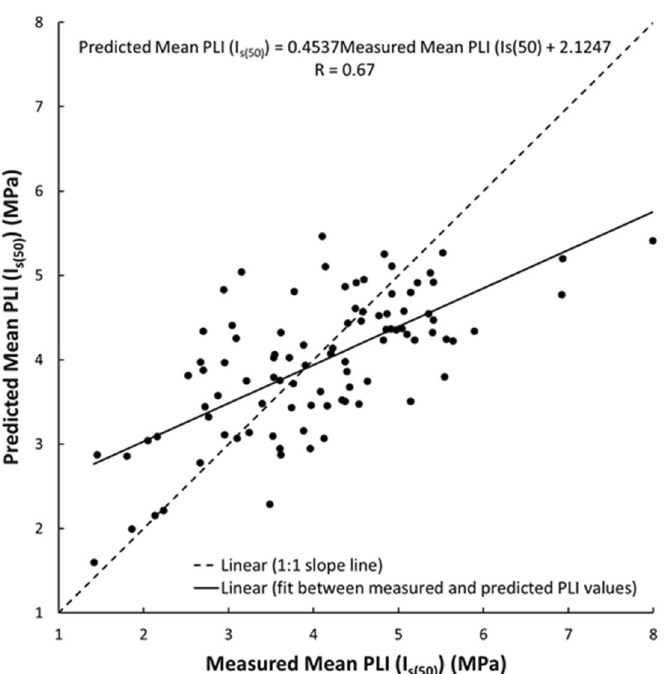
Figure 20. Cross-correlation of the measured and predicted values estimated from V p in terms of PLI (I s(50) ) values of